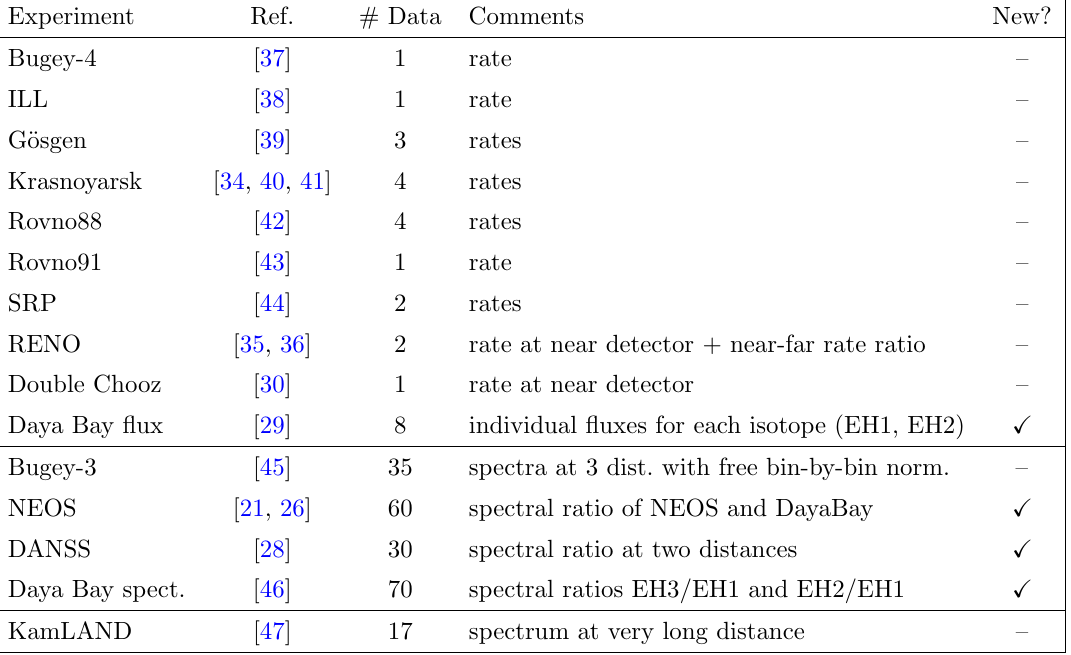
Daya Bay spect. Table 2 . Data from reactor neutrino experiments used in our analysis. Data are separated into integrated rate measurements, data on the neutrino energy spectrum, and the very-long baseline experiment KamLAND. The column \# Data" gives the number of data points entering the cor- responding (cid:31) 2 function. The total number of data points is 239. The acronym \EH" stands for \experimental hall" in Daya Bay, with EH1, EH2 being the two near detectors halls and EH3 the far detector hall. The last column highlights the most recent data sets (since summer 2016). In